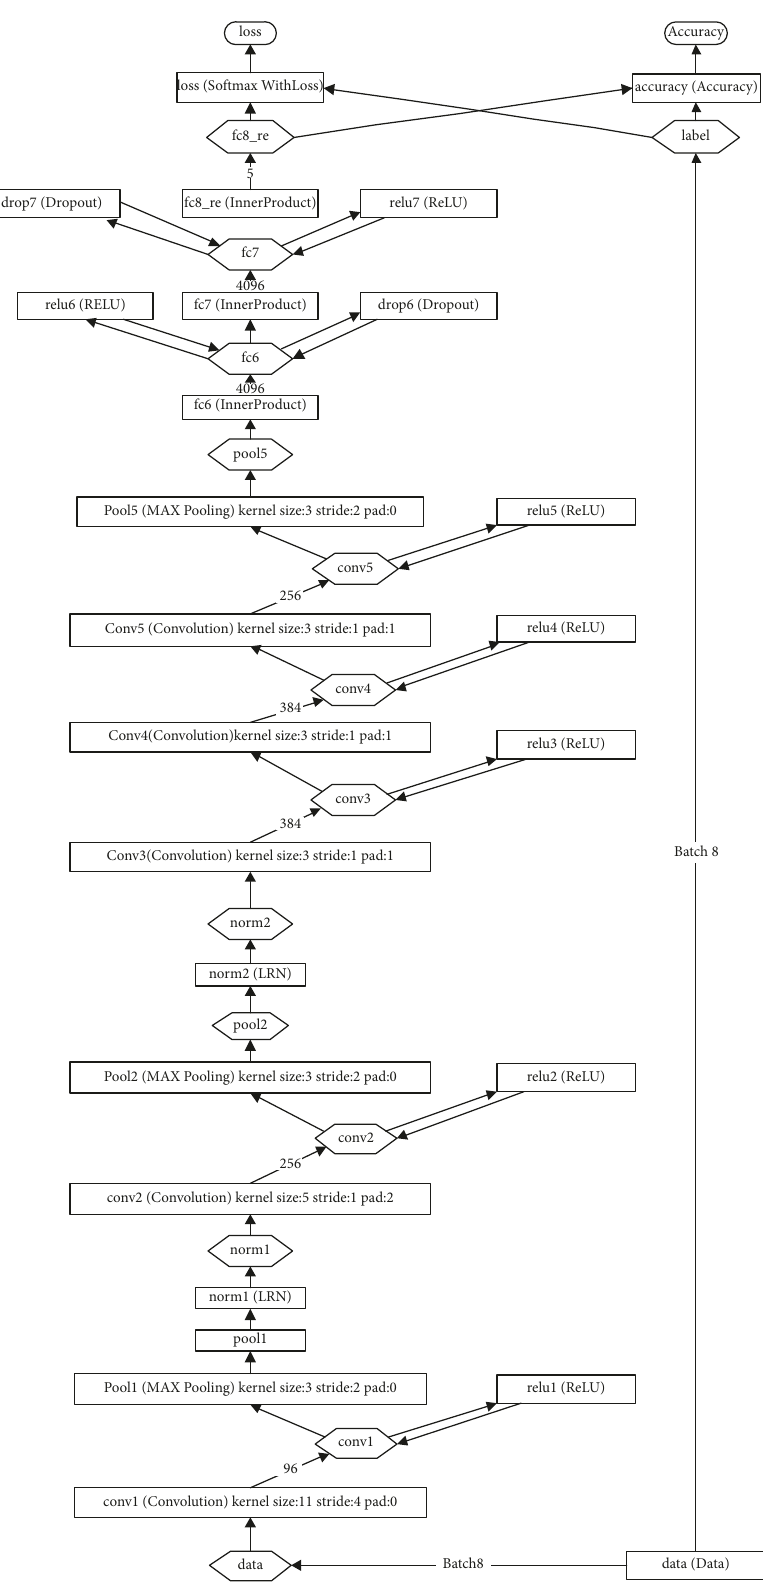
Figure 10: Convolutional neural network